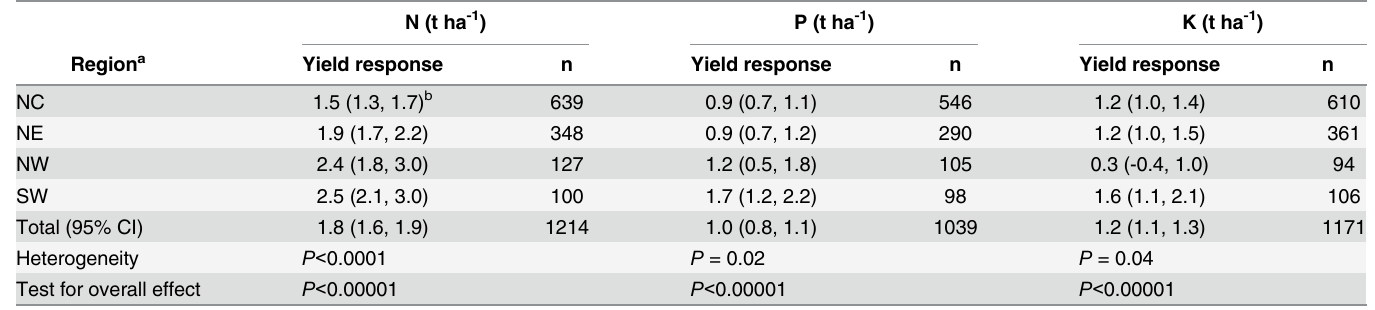
Table 2. Yield responses to applied N, P, and K for maize in different production regions of